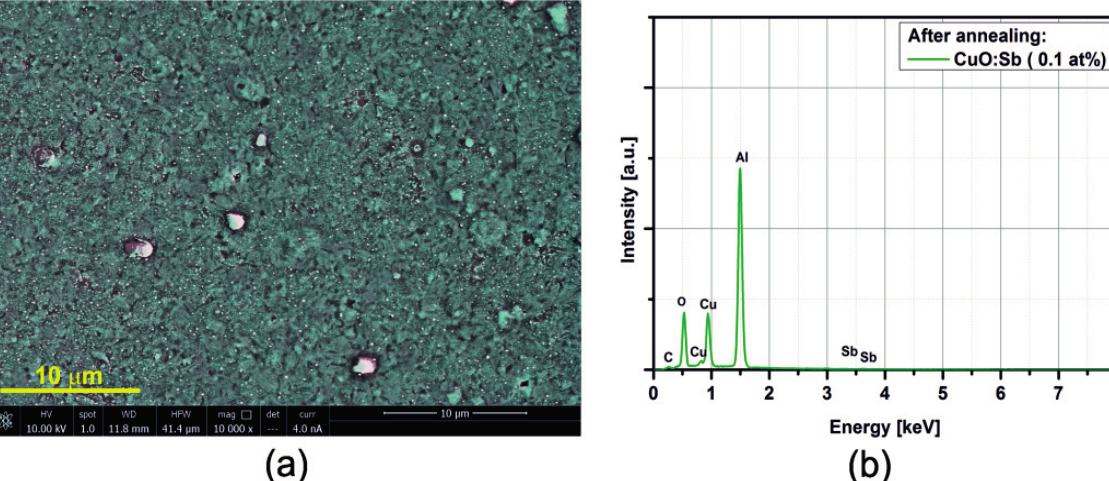
Figure 9. ( a ) SEM image; ( b ) EDX distribution of the Pt:CuO-based sensor (Pt: 1.1at%).